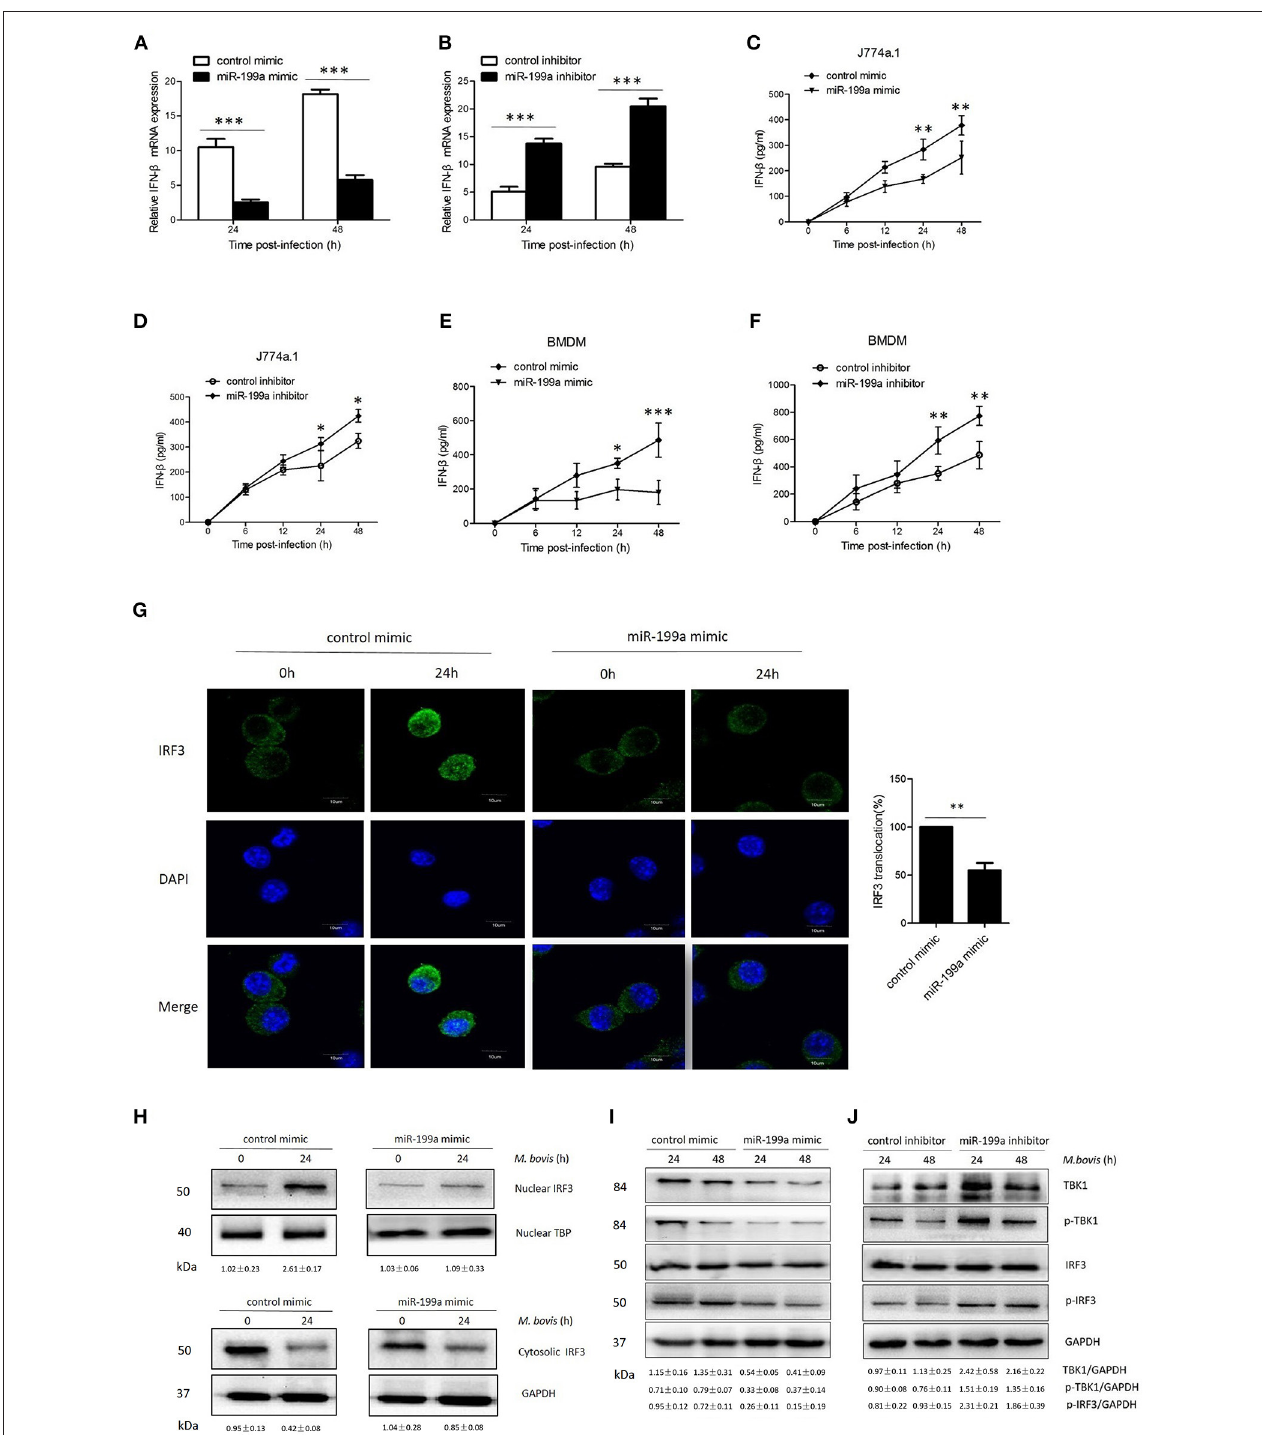
FIGURE 5 | miR-199a impairs interferon- β (IFN- β ) production by inhibiting TANK-binding kinase 1 (TBK1)-dependent pathway. J774a.1 cells were treated with miR-199a mimic or inhibitor for 24h, and then infected with Mycobacterium bovis ( M. bovis ) at a MOI of 10 for the indicated time. mRNA levels of IFN- β (A,B) were determined by Quantitative Real-Time PCR. J774a.1 cells and mouse bone marrow monocyte-derived macrophages (BMDMs) were treated with miR-199a mimic or inhibitor for 24h, followed by M. bovis infection at a MOI of 10 for the indicated time. IFN- β production (C–F) was measured by ELISA assay. (G) Immunofluorescence staining of IRF3 (green) of J774a.1 cells infected with M. bovis at a MOI of 10 for 0 or 24h. The proportion of nuclear IRF3 is shown (right). Cell nuclei were dyed with DAPI (blue). Approximately 20 cells were used to calculate the IRF3 nuclear translocation proportion. Image J software was used for the analysis. (H) J774A.1